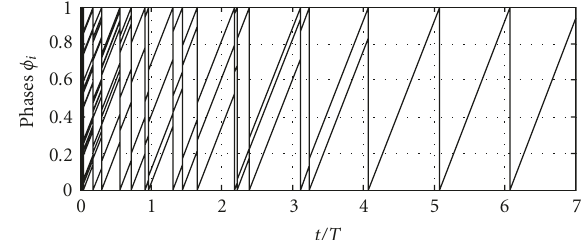
Figure 2: Phase representation of the synchronization of N = 30 PCOs.